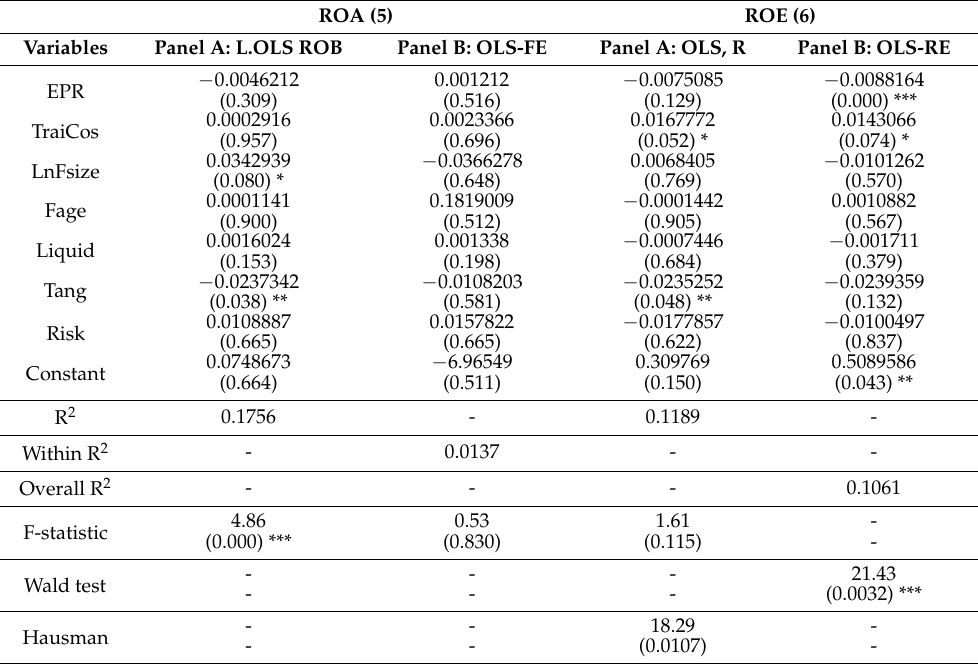
Table 7. Regression analysis of model (5) and (6).